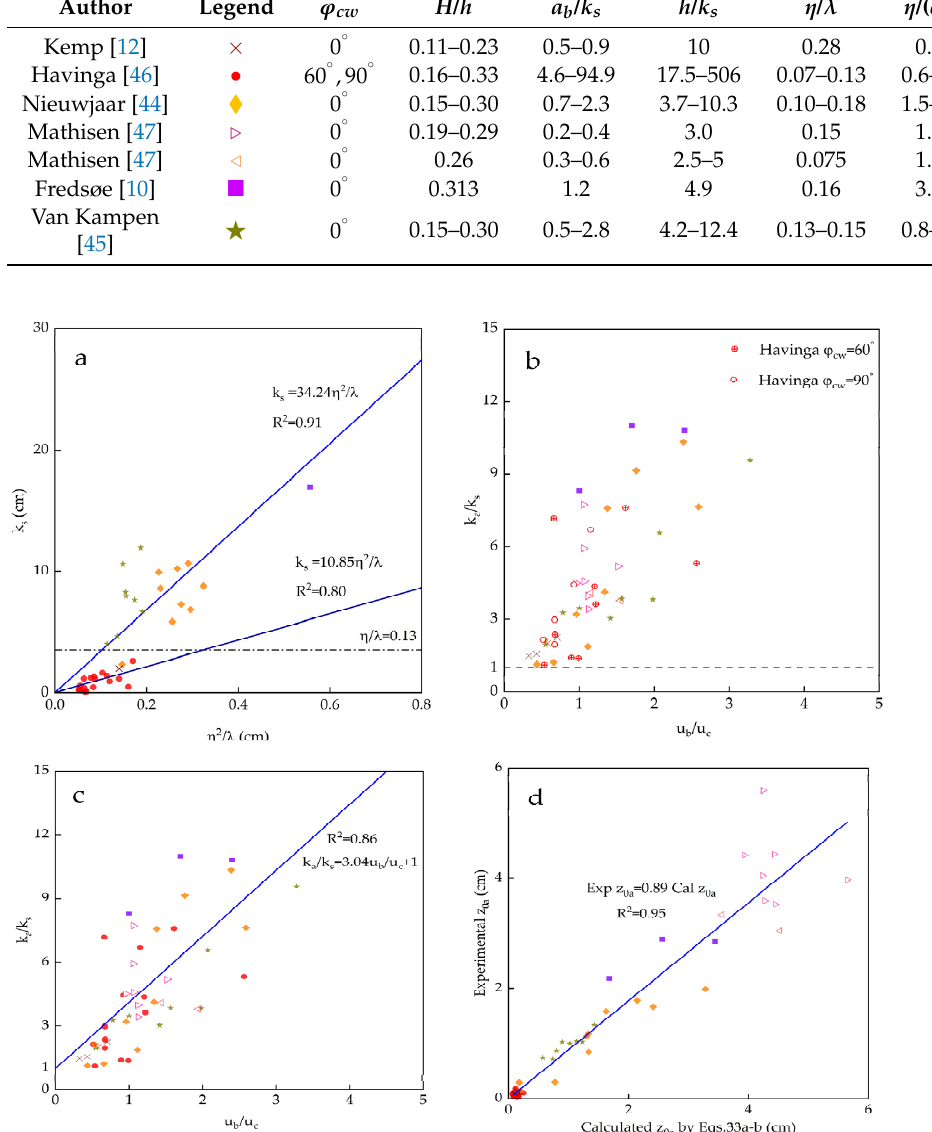
Figure 6. Experimental k s , k a and linear regression. ( a ) k s as a function of η 2 / λ ; ( b ) experimental k a / k s , where the data in Havinga [46] are divided into those with ϕ cw = 60 ◦ and those with ϕ cw = 90 ◦ ; ( c ) k a / k s as a function of u b / u c ; ( d ) linear regression between experimental z 0 a and calculated z 0 a . Table 2. Experiments conditions. The legends in the table are applicable to Figure 6a–d.